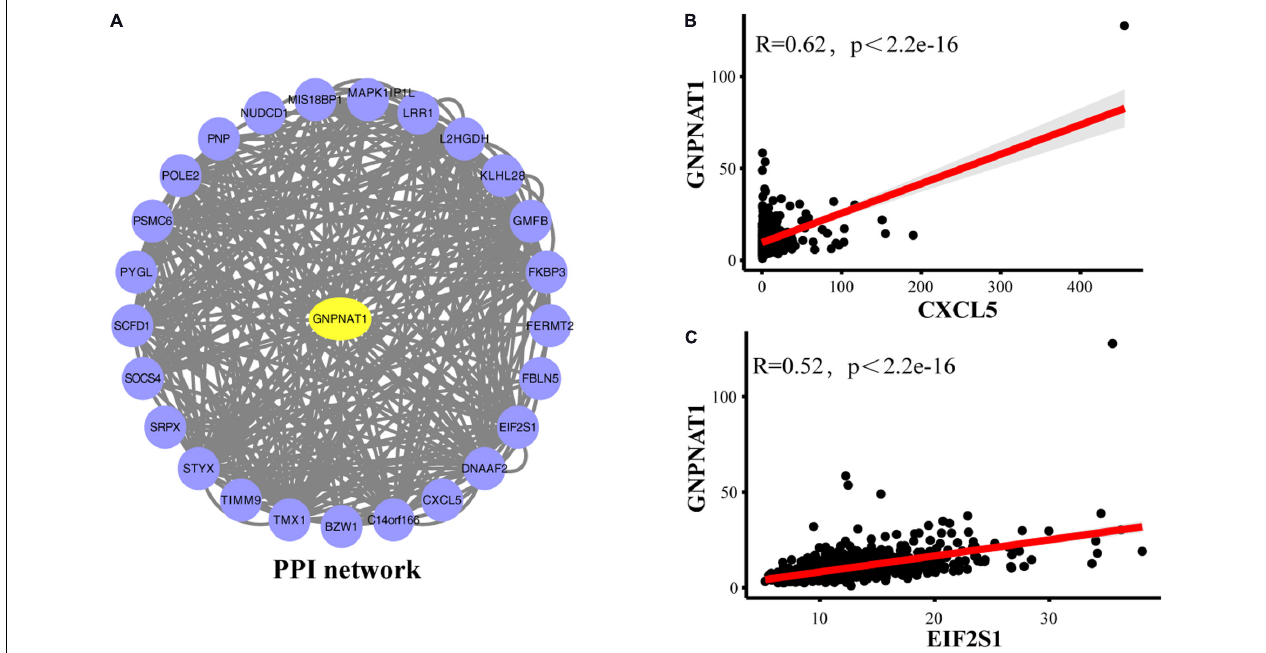
FIGURE 8 | The PPI network of GNPNAT1 in LUAD. (A) The PPI network was constructed by database. The correlation between GNPNAT1 and CXCL5 (B) /EIF2SI (C) .